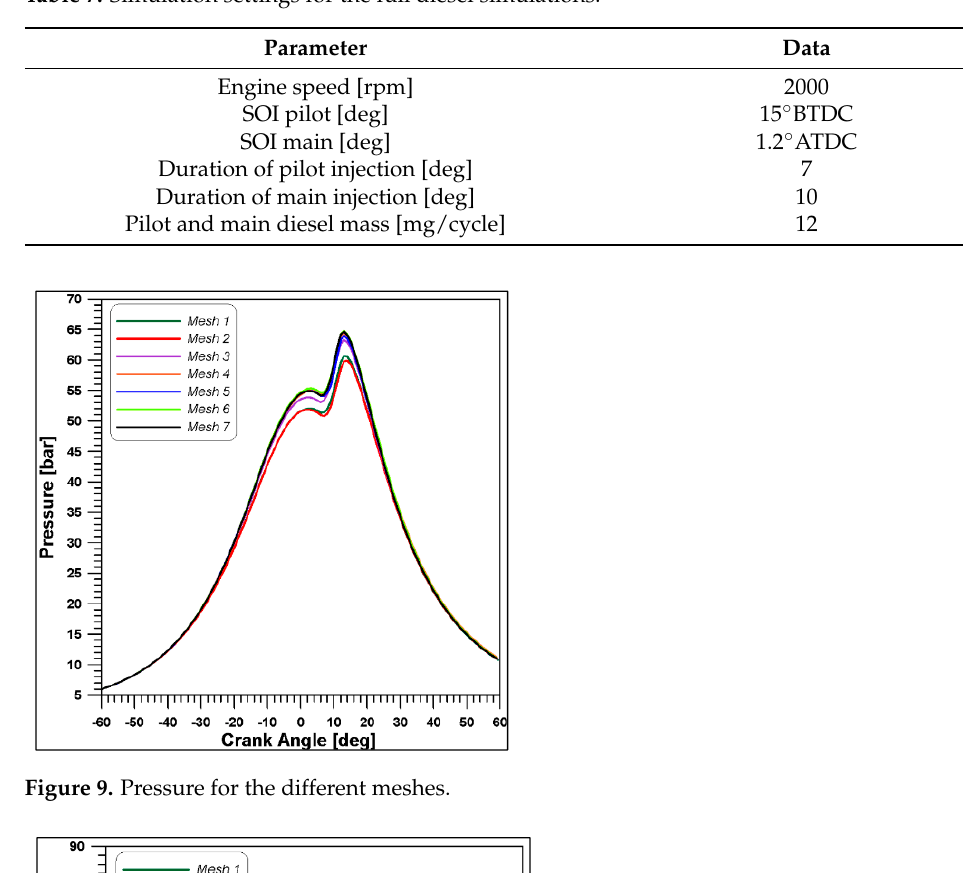
Figure 11. Mass inside the cylinder. Figure 12. Mesh#4.